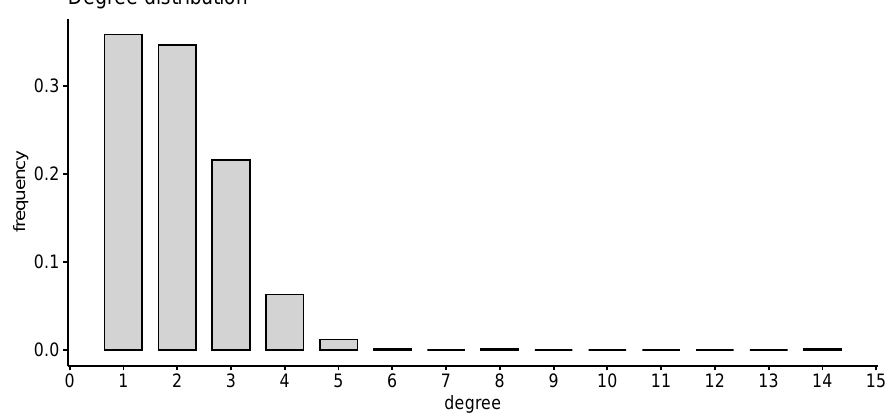
Figure 8. Degree distribution of the rule-based graph presented in Figure